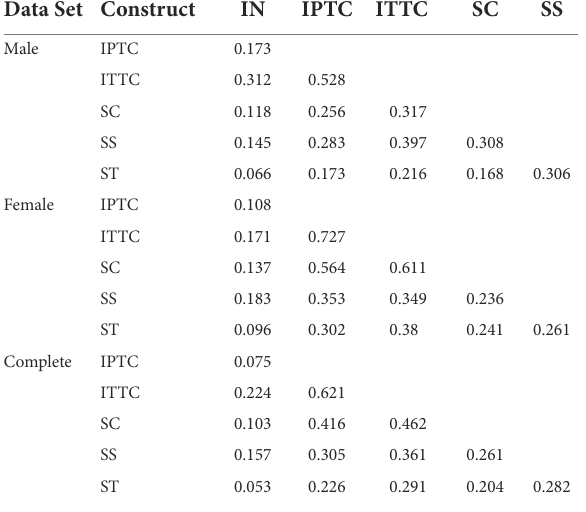
TABLE 3 Discriminant